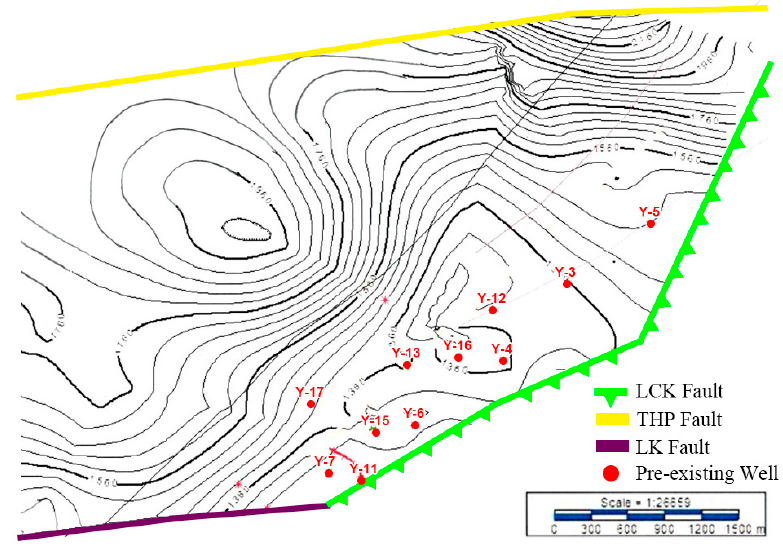
Figure 1. Structural map of the Yutengping (YTP) formation in the Y-field.